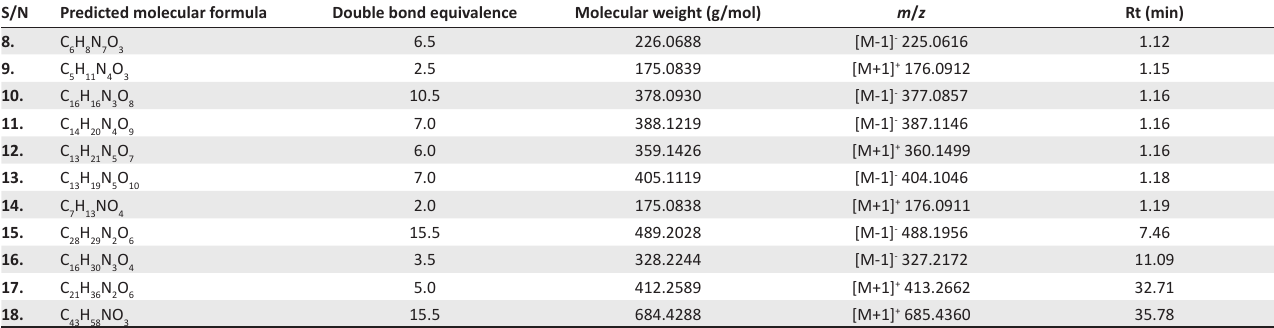
TABLE 2: Unidentified compounds in Alchornea laxiflora